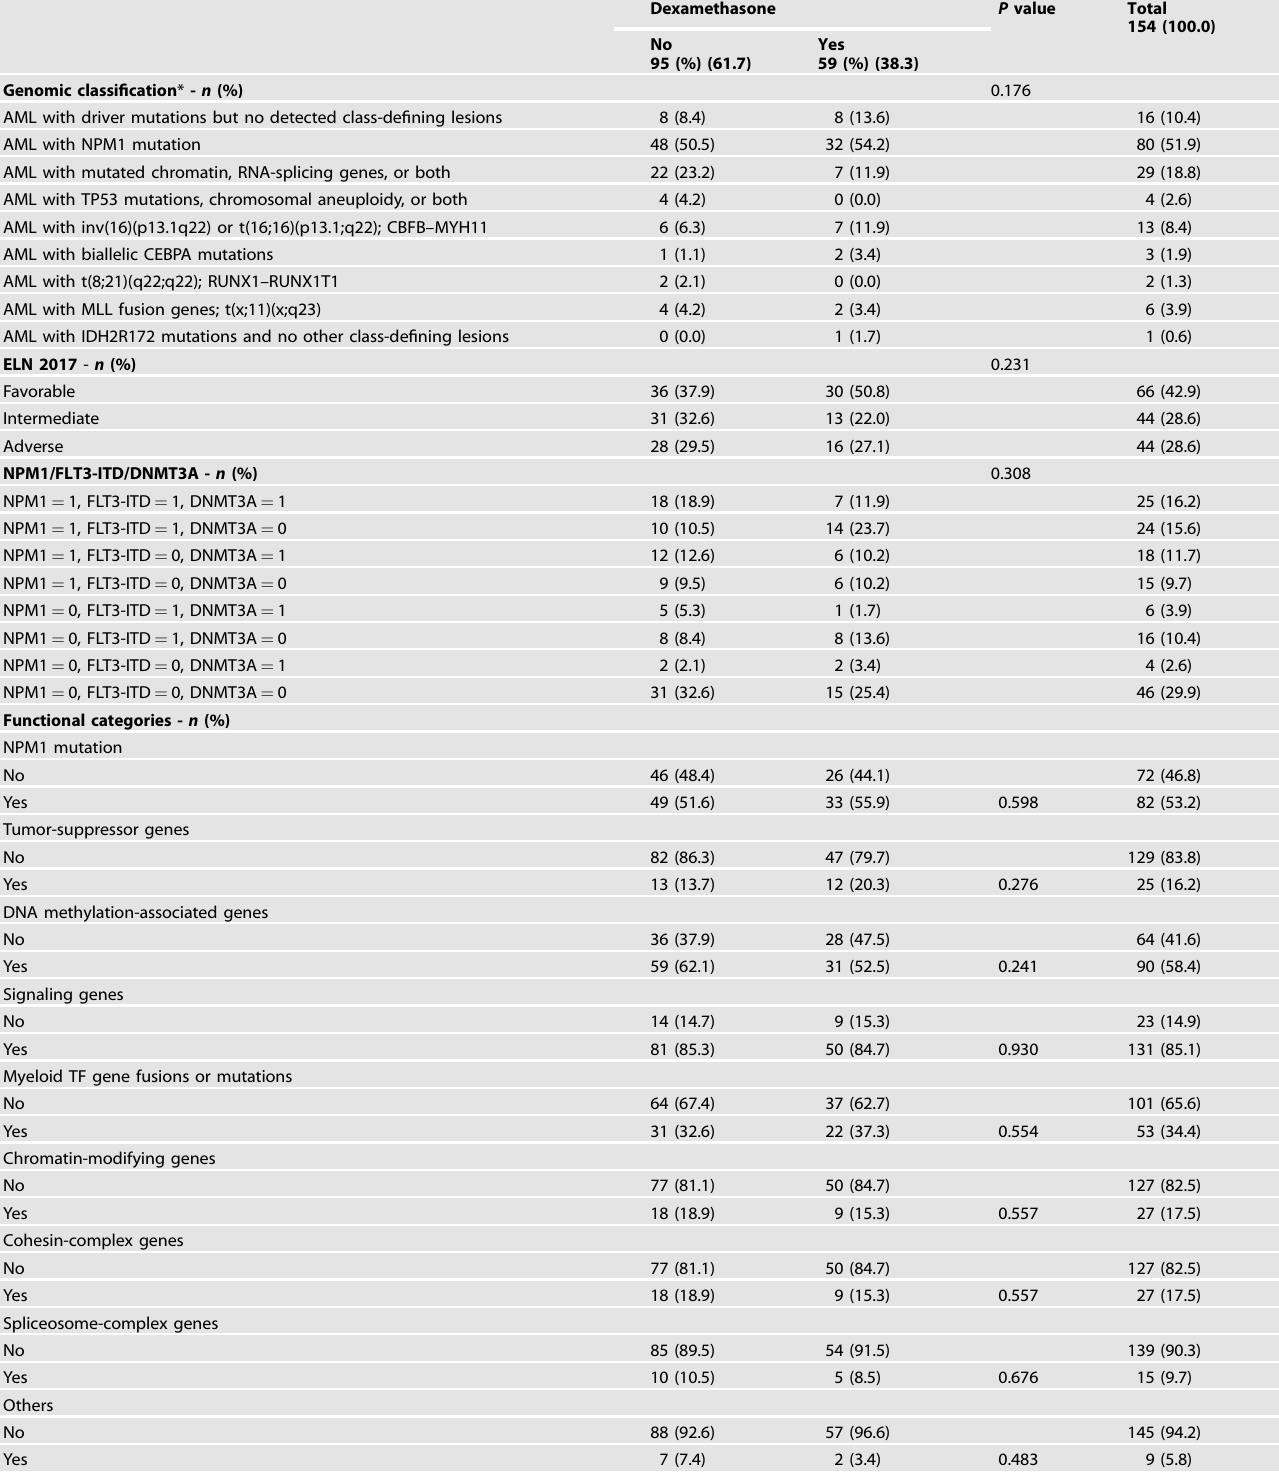
Table 1. Genetic Classi fi cations of Hyperleukocytic AML.